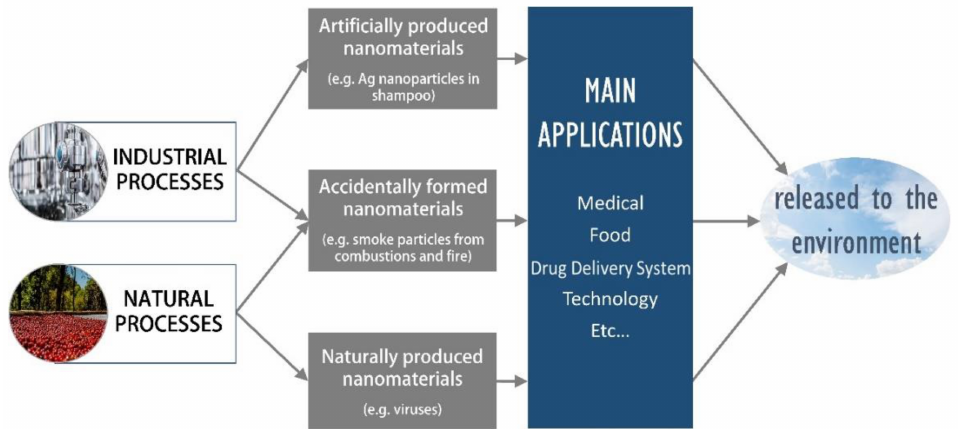
Figure 1. Nanoparticles classification and main